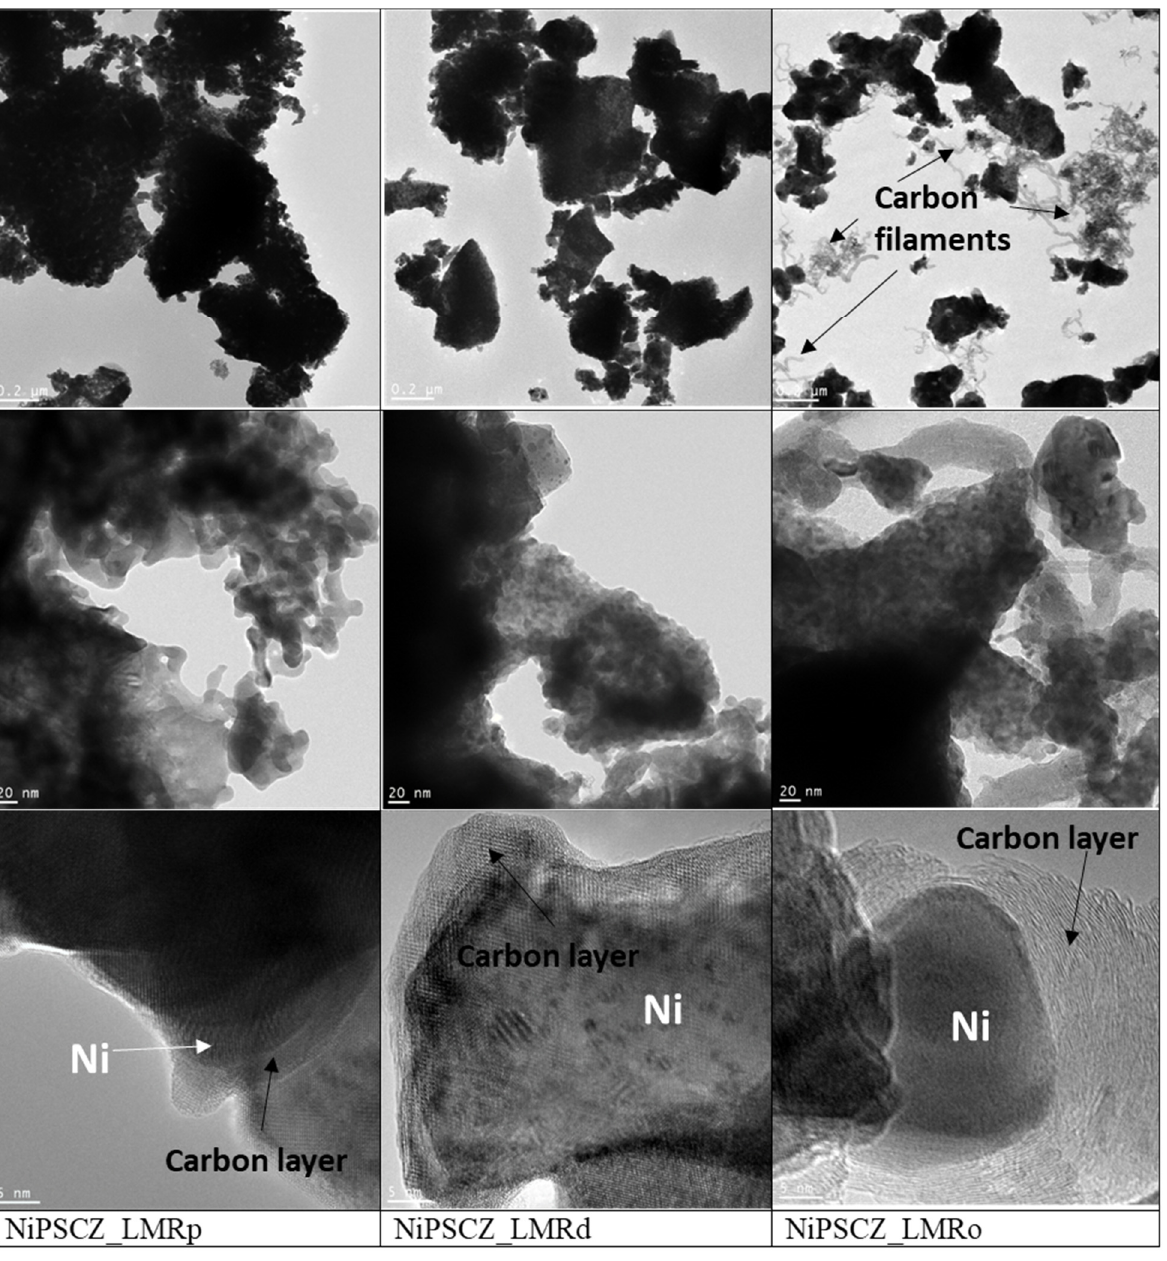
Figure 6. The HR TEM images of the catalysts after ESR